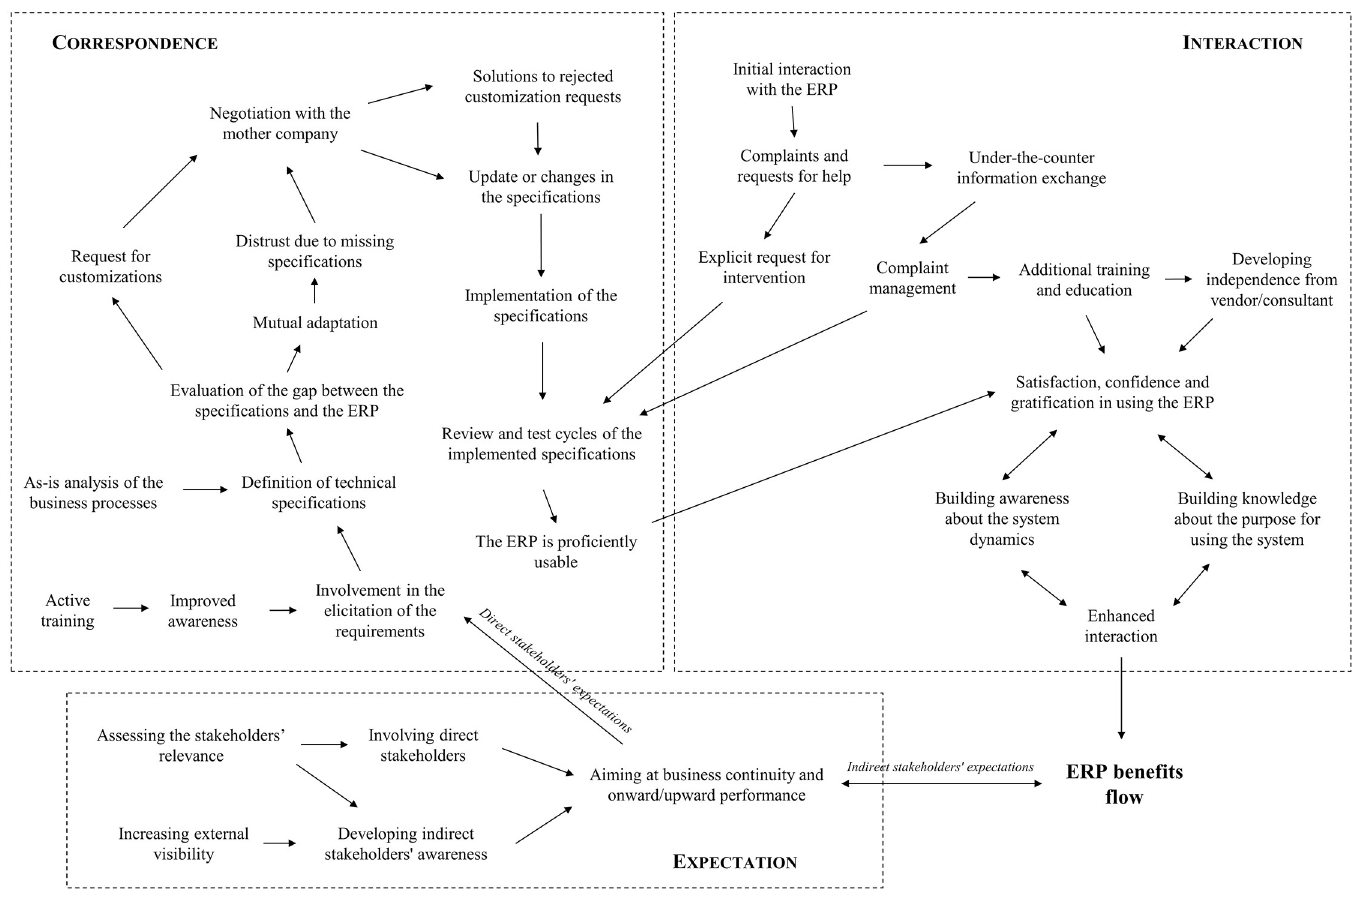
Fig 5. The ERP success causal